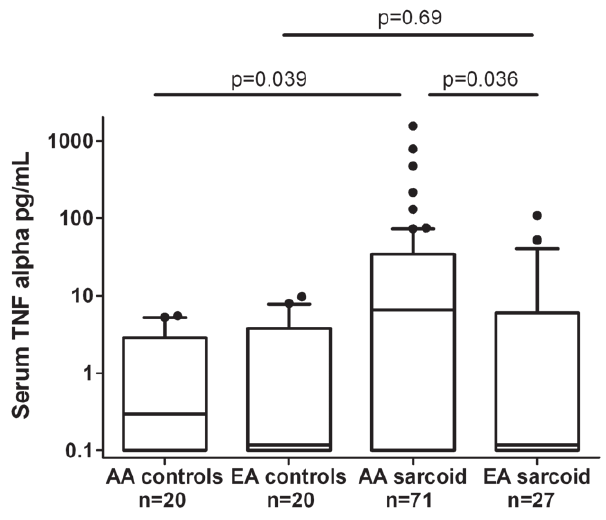
Figure 1. Serum TNF- a levels in sarcoidosis patients and controls in each ancestral background. Lines represent the median, boxes show the interquartile ranges, and error bars show the 10 th and 90 th percentiles with dots indicating outliers. P-values by Mann-Whitney U test.